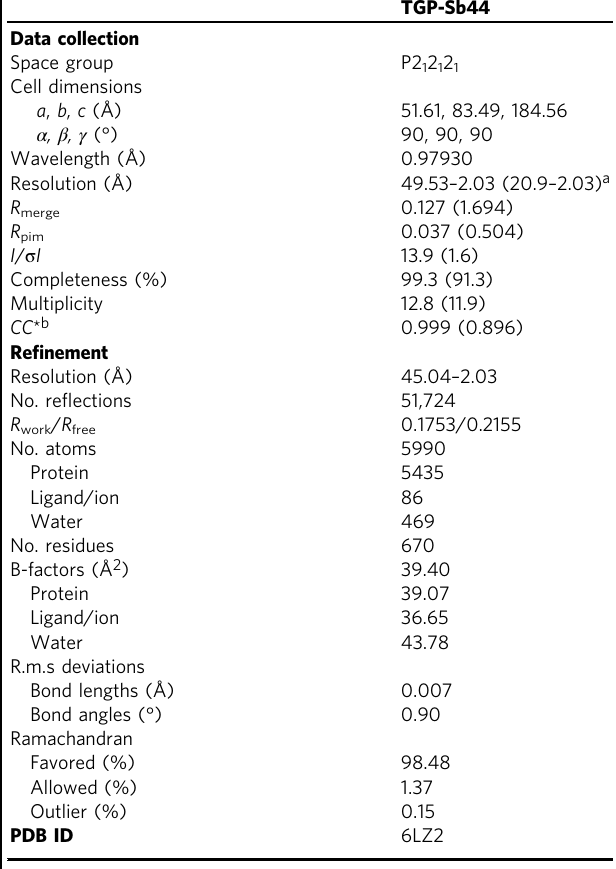
Table 2 Data collection and re fi nement